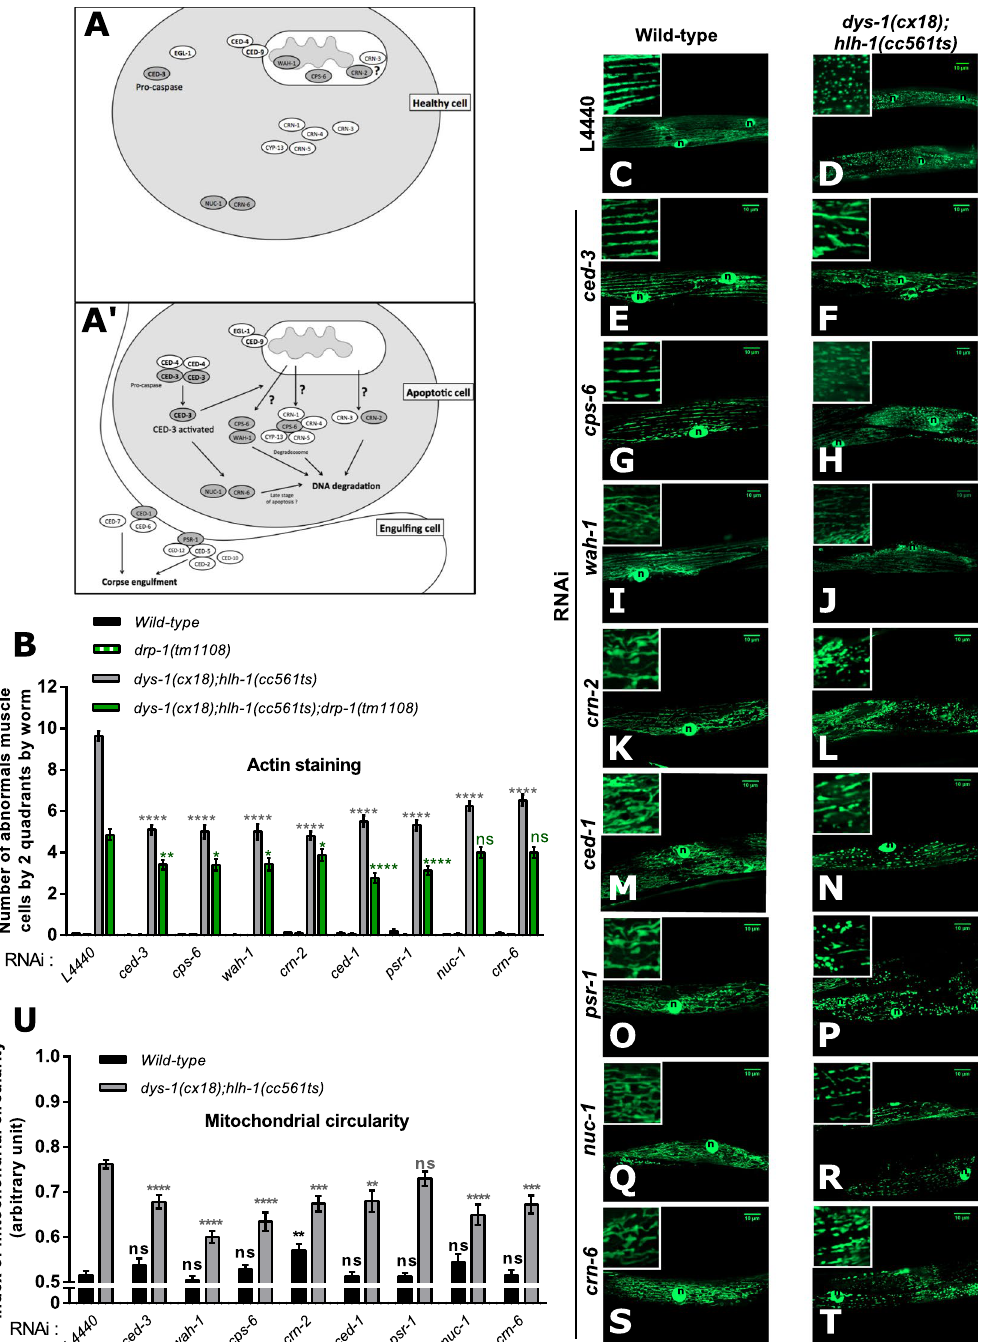
Figure 4. Genetic manipulation of apoptosis impacts muscle degeneration and mitochondrial dynamics of dys- 1(cx18);hlh-1(cc561ts) mutant worms. Simplified schematic of the sub-cellular localization, in healthy ( A ) and apoptotic ( A’ ) cells, of the main apoptotic factors involved in the inducing and execution phases of apoptosis in C. elegans . Gene names in dark gray indicate the genes, which knock-downs by RNAi, were tested on different phenotypes of dys-1(cx18);hlh-1(cc561ts) mutant and wild-type worms. ( B ) Number of abnormal C. elegans body wall muscle cells by two quadrants quantified by phalloïdin staining in wild-type worms or drp-1(tm1108) mutant worms or dys-1(cx18);hlh-1(cc561ts) mutant worms or dys-1(cx18);hlh-1(cc561ts);drp-1(tm1108) mutant worms fed either with the empty vector L4440 or with the indicated RNAi against executors of cell death (n = 90 worms at least). Representative confocal images of the mitochondrial network organization visualized with the ccIs4251 transgene in C. elegans body wall muscle cells of: ( C ) wild-type worms or ( D ) dys-1(cx18);hlh- 1(cc561ts) mutant worms fed with empty vector L4440; of ( E ) wild-type worms or ( F ) dys-1(cx18);hlh-1(cc561ts) mutant worms fed with ced-3 RNAi; of ( G ) wild-type worms or ( H ) dys-1(cx18);hlh-1(cc561ts) mutant worms fed with cps-6 RNAi; of ( I ) wild-type worms or ( J ) dys-1(cx18);hlh-1(cc561ts) mutant worms fed with wah-1 RNAi; of ( K ) wild-type worms or ( L ) dys-1(cx18);hlh-1(cc561ts) mutant worms fed with crn-2 RNAi; of ( M